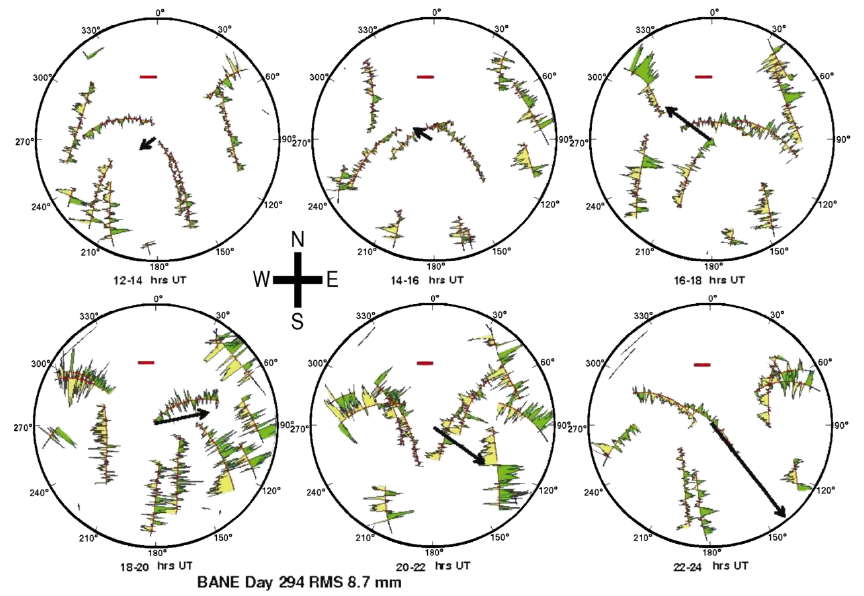
Figure 17: Post-fit one way phase residuals for station BANE on 21st of October 2002 (doy 294), from 12h 2 Fig. 17. Post-fit one way phase residuals for station BANE on 21 October 2002 (doy 294), from 12:00 to 24:00UTC. Black arrows show to 24h. Black arrows show the average total horizontal gradient for each 2h interval (pointing towards 3 the average total horizontal gradient for each 2h interval (pointing towards maximum delay). Gradient values cover amplitudes from 6mm maximum delay). Gradient values cover amplitudes from 6 mm (12-14 h) to 37 mm (22-24 h). 4 (12:00–14:00UTC) to 37mm